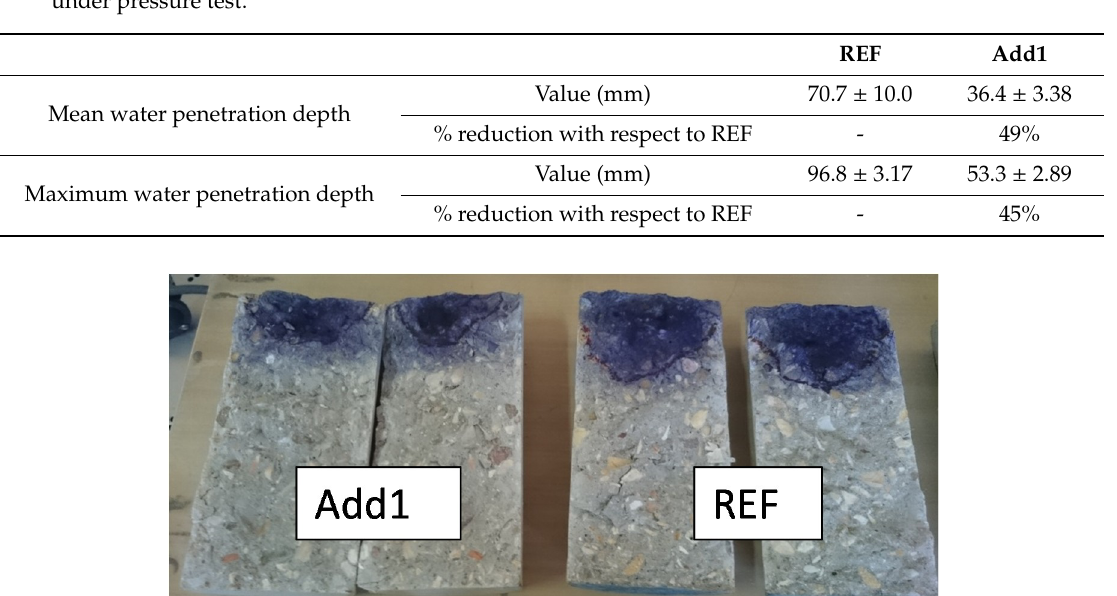
Table 5. Total porosity and pore size distribution (%) of the concrete samples after 90 days.